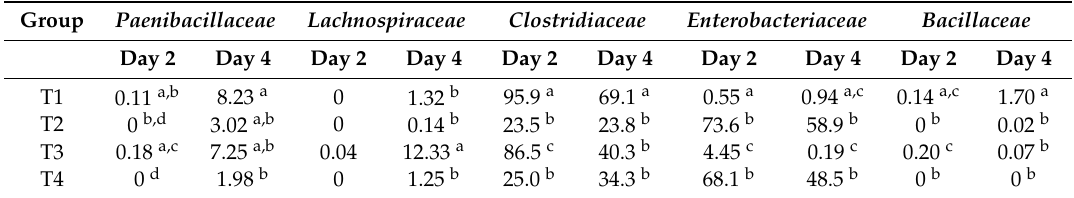
Table 2. The top listed median relative abundance (by %) of observed families in the ceca of day 2 and day 4 birds.